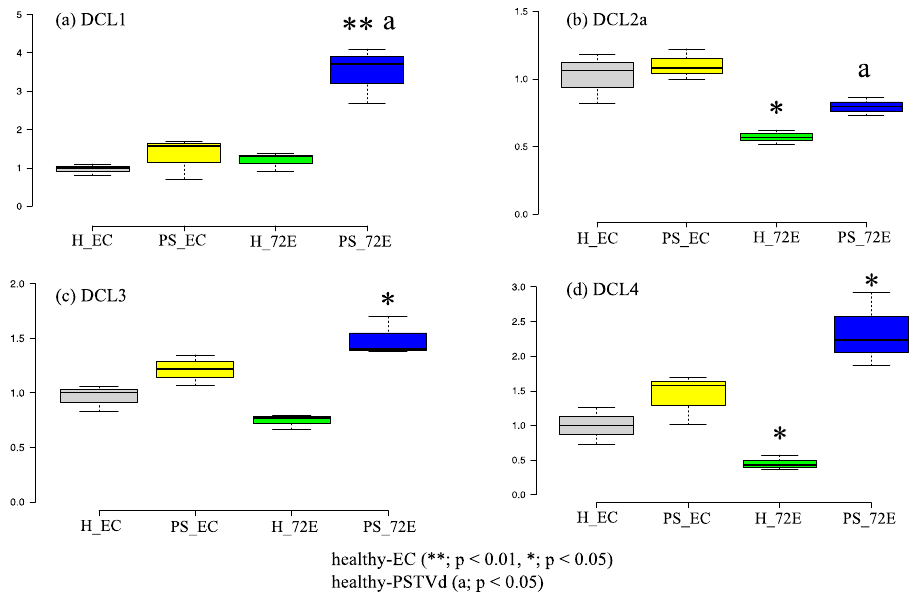
Figure 4. RT-qPCR analysis of endogenous SlDCL1 , 2a , 3 , and 4 mRNAs in lines 72E and EC with or without infection of potato spindle tuber viroid (PSTVd) using the leave at 3 wpi. Levels of SlDCL2a and 4 mRNAs in line 72E were significantly lower compared to those in the empty cassette before PSTVd infection, suggesting that endogenous SlDCL2a and 4 mRNAs were successfully down-regulated in line 72E ( b , d ). Levels of mRNAs of SlDCL1 , 3 and 4 were significantly up-regulated in line 72E by PSTVd infection ( a , c , d ). Surprisingly, SlDCL2a was also up-regulated in line 72E compared to the healthy line, suggesting that the expression of tomato DCL genes are significantly activated by PSTVd infection ( b ). The assay was repeated twice, and each analysis consisted of three biological replicates collected from three plants per treatment. The values with the double asterisk (**; p < 0.01) and single asterisk (*; p < 0.05) were statistically significant at 1% and 5% levels compared to healthy-EC. The values with “a” (a; p < 0.05) were statistically significant at the 5% level compared to PSTVd-EC.